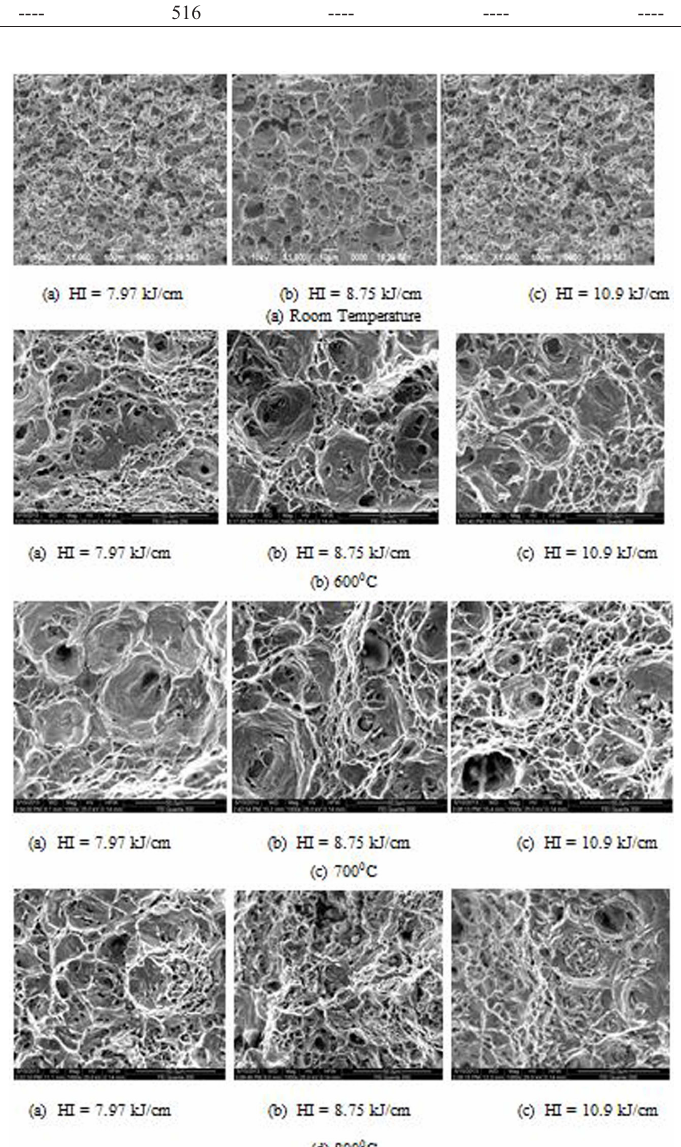
Figure 6. Fractographs of tensile samples under temperature as (a) RT, (b) 600°C, (c) 700°C and (d) 800°C under different heat